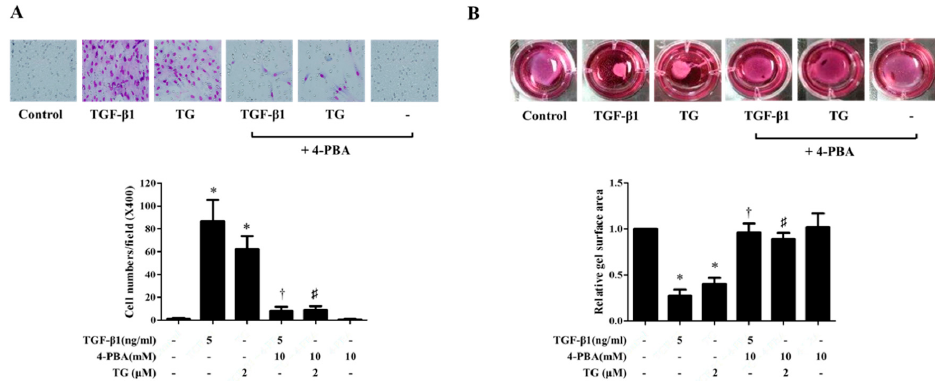
Figure 6. 4-PBA ameliorates TGF- β 1-induced migration and collagen contraction in nasal fibroblasts. Nasal fibroblasts were pre-treated with 4-PBA (10 mM) and stimulated with TGF- β 1 (5 ng/mL) or TG (2 µ M) for 48 h. Cells treated with TG (2 µ M) were used as a positive control. ( A ) In Transwell ® migration assays, invasive cells were counted in five high power fields to determine the average number of migrated cells per high power field. ( B ) Collagen gel contraction was assessed by measuring the collagen gel surface area. Data are presented as mean ± SEM and are representative of at least three independent experiments.